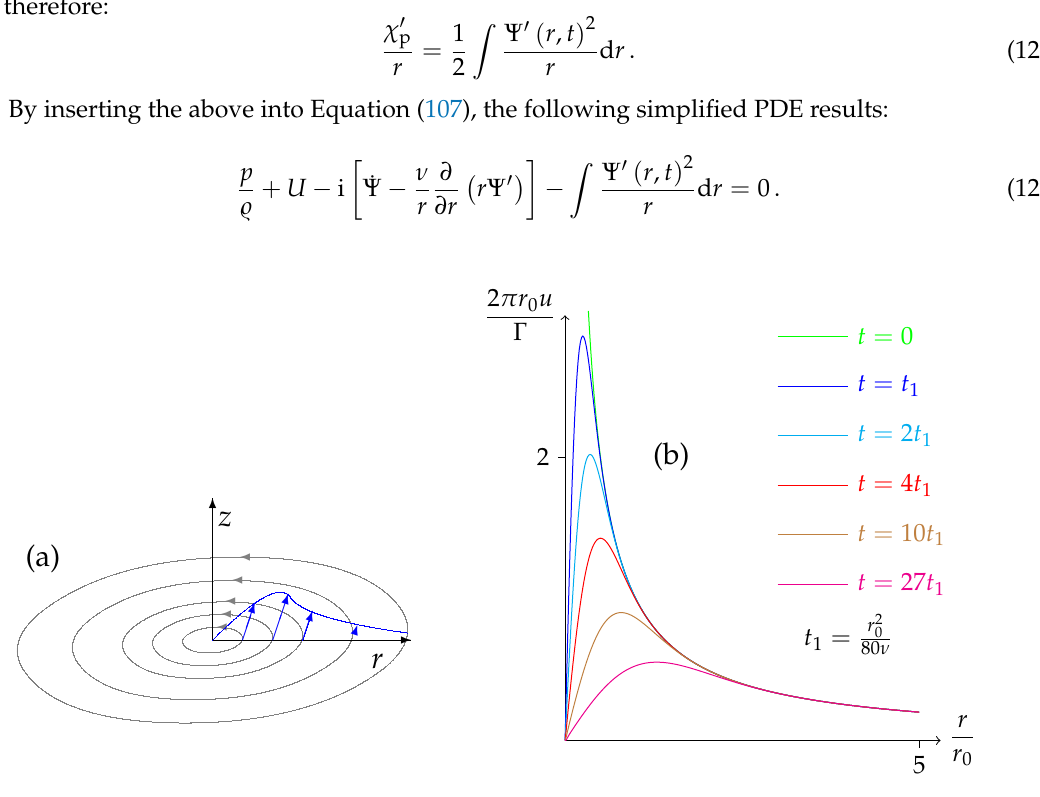
Figure 3. Vortex geometry ( a ) and time evolution of the velocity profile ( b